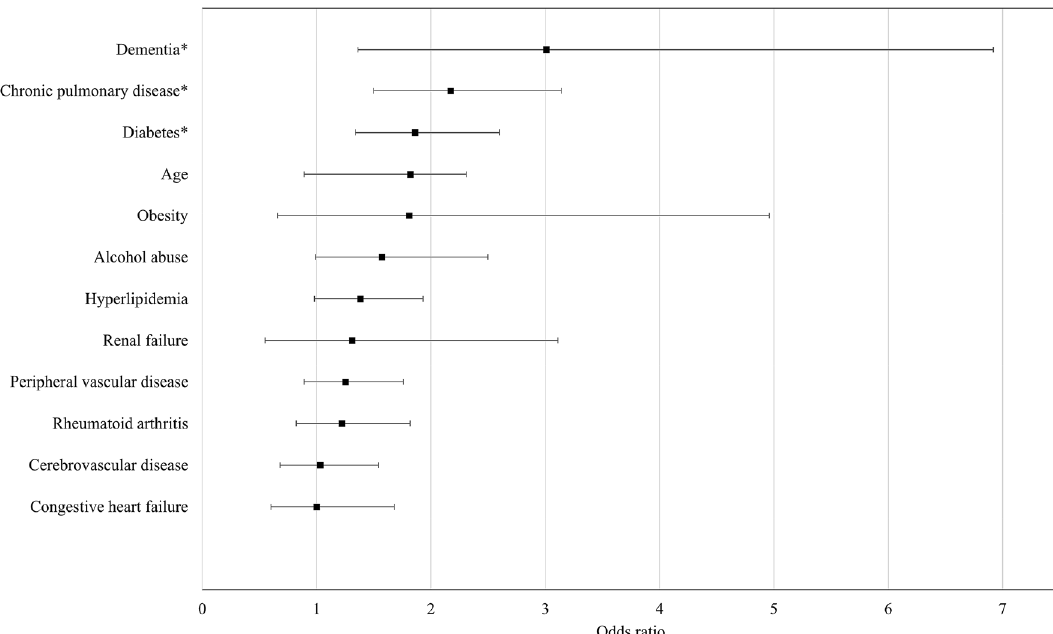
Figure 2. Odds ratio by multiple logistic regression analysis. The asterisk (*) indicates significant high